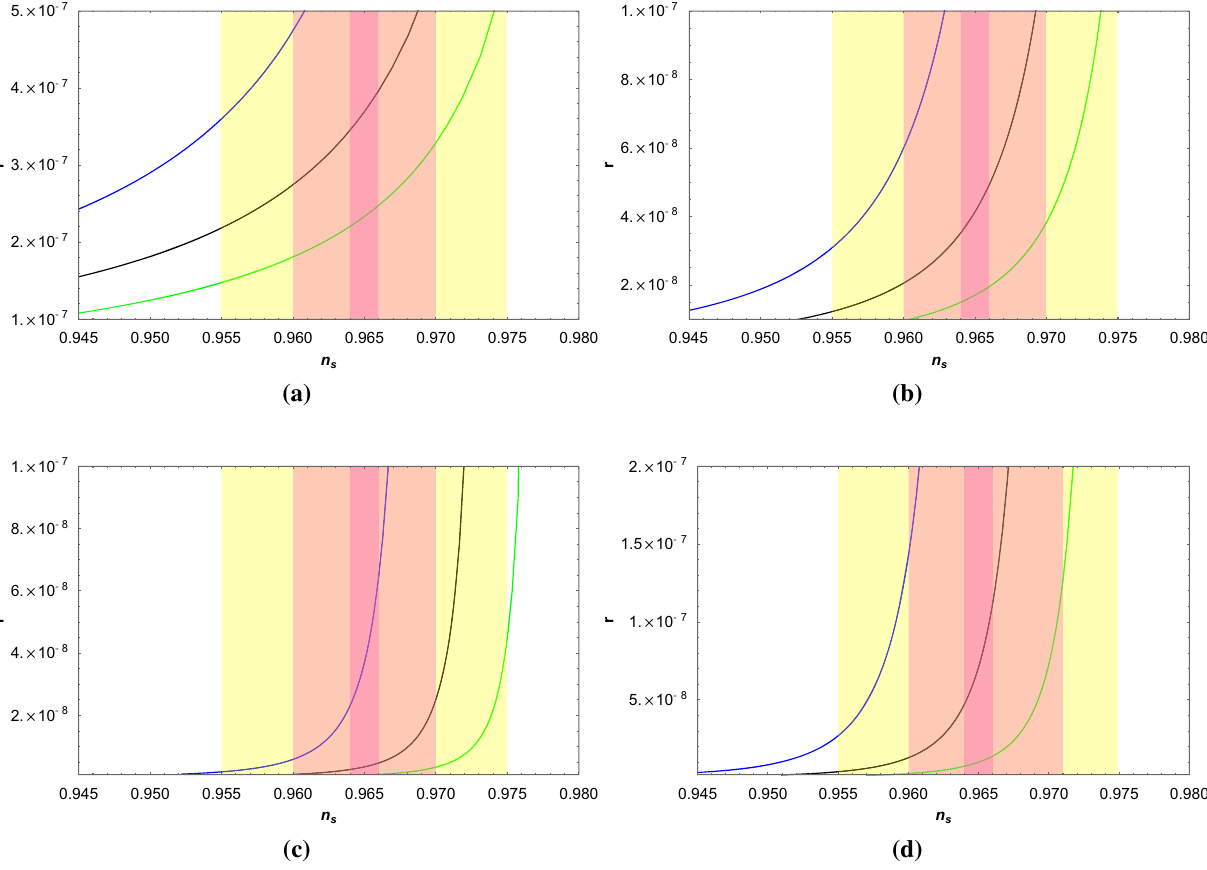
The light pink shaded region corresponds to the 1- σ bound and the yellow shaded region is 2- σ bound on n s from Planck’18 [TT,TE, EE+lowE+lensing+BK15]. The dark pink shaded region corresponds to the 1- σ bound of future CMB observations using same central value for n s [52,53]